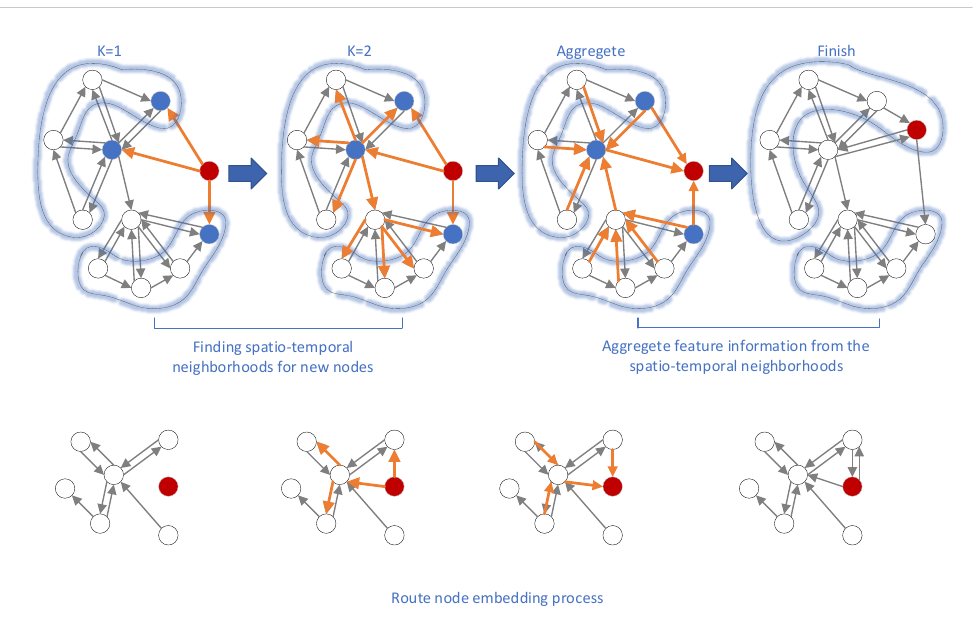
Figure 5. The spatio-temporal graph neural network prediction